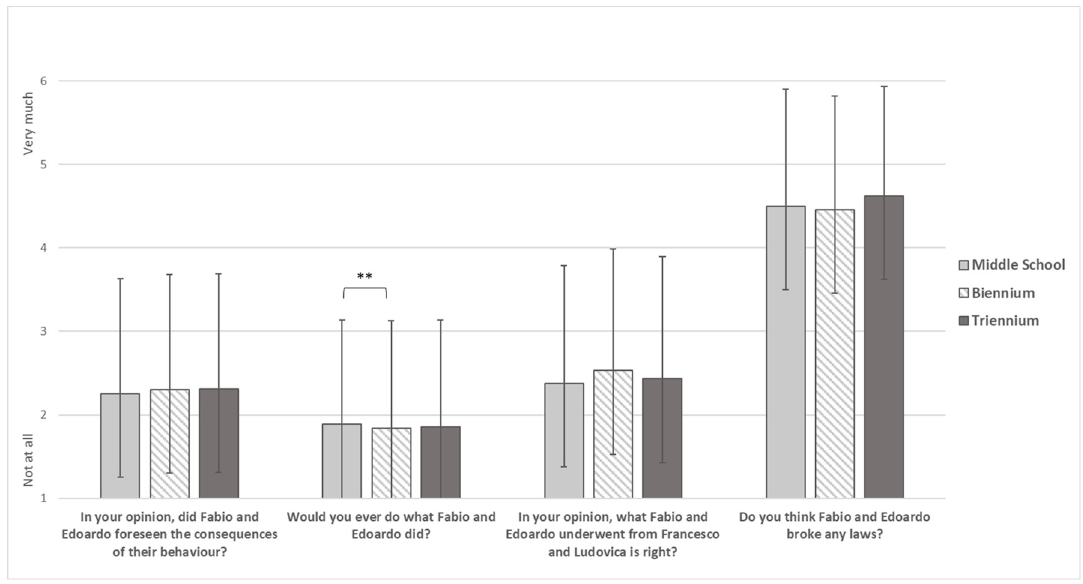
Figure 2. Motivations underlying the offense Note. ** = p < 0.01.